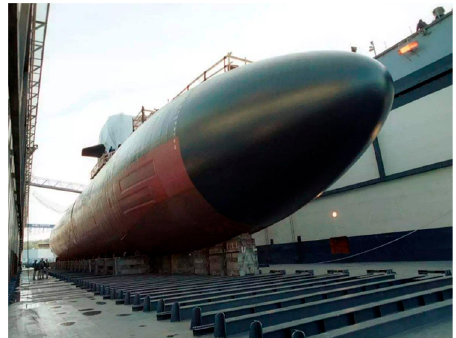
Figure 1. Submarine pressure hull.